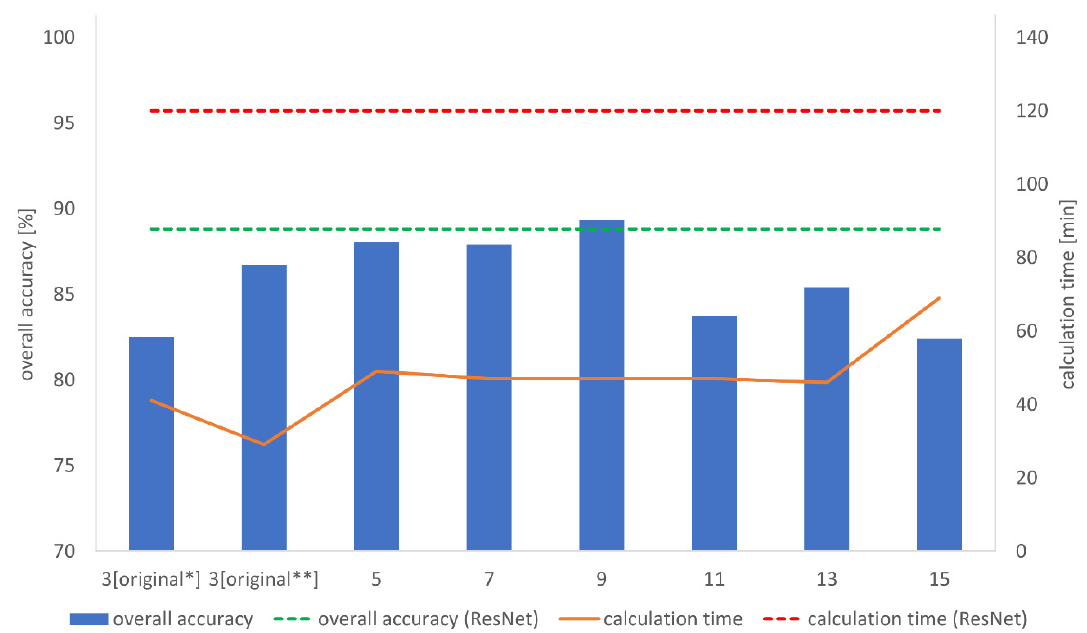
Figure 5. Overall accuracies and calculation times of the models with the filter sizes of max-pooling (original *: original (input image size: 224 × 224), original **: original (input image size: 512 × 512)).